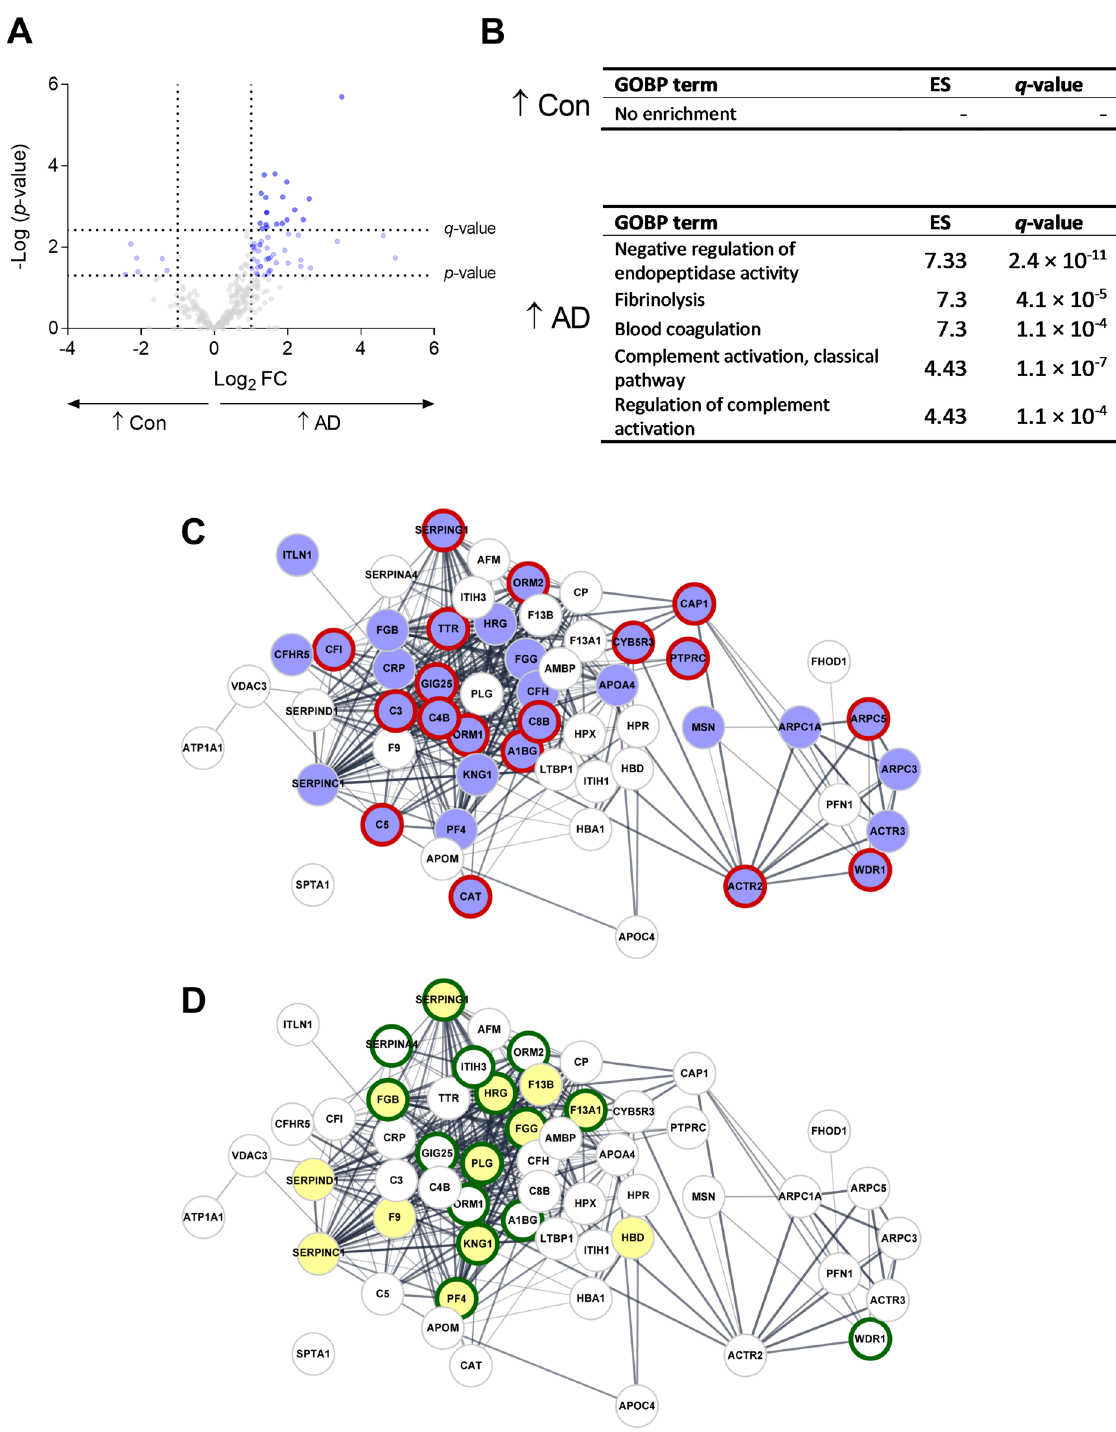
Figure 4. Significantly expressed proteins comparing AD patients and healthy individuals. ( A ) Volcano plot comparing AD patients with controls showed 57 proteins up-regulated in the AD group with 19 of them having a significant q -value and six proteins up-regulated in the control group. A cut-off value of a log 2 FC > 1 or < − 1 is indicated, as well as p -value (light blue) and q -value (dark blue) < 0.05 cut-off lines. ( B ) Identified significant gene ontology terms for top five biological processes (GOBP), together with their enrichment scores (ES) and q -values are indicated. Downregulated proteins in AD patients show no enrichment of GOBP terms, while upregulated proteins show five terms from three different clusters. ( C ) Protein–protein interaction network analysis of 56 up-regulated proteins in AD. The nodes represent the proteins and the edges show their interactions. A significantly higher number of edges (334) is identified compared to the expected (35). Enrichment analysis reveals that these proteins are part of the immune system process (blue nodes) and leukocyte mediated immunity (red borders), and ( D ) platelet degranulation (green borders) and blood coagulation (yellow